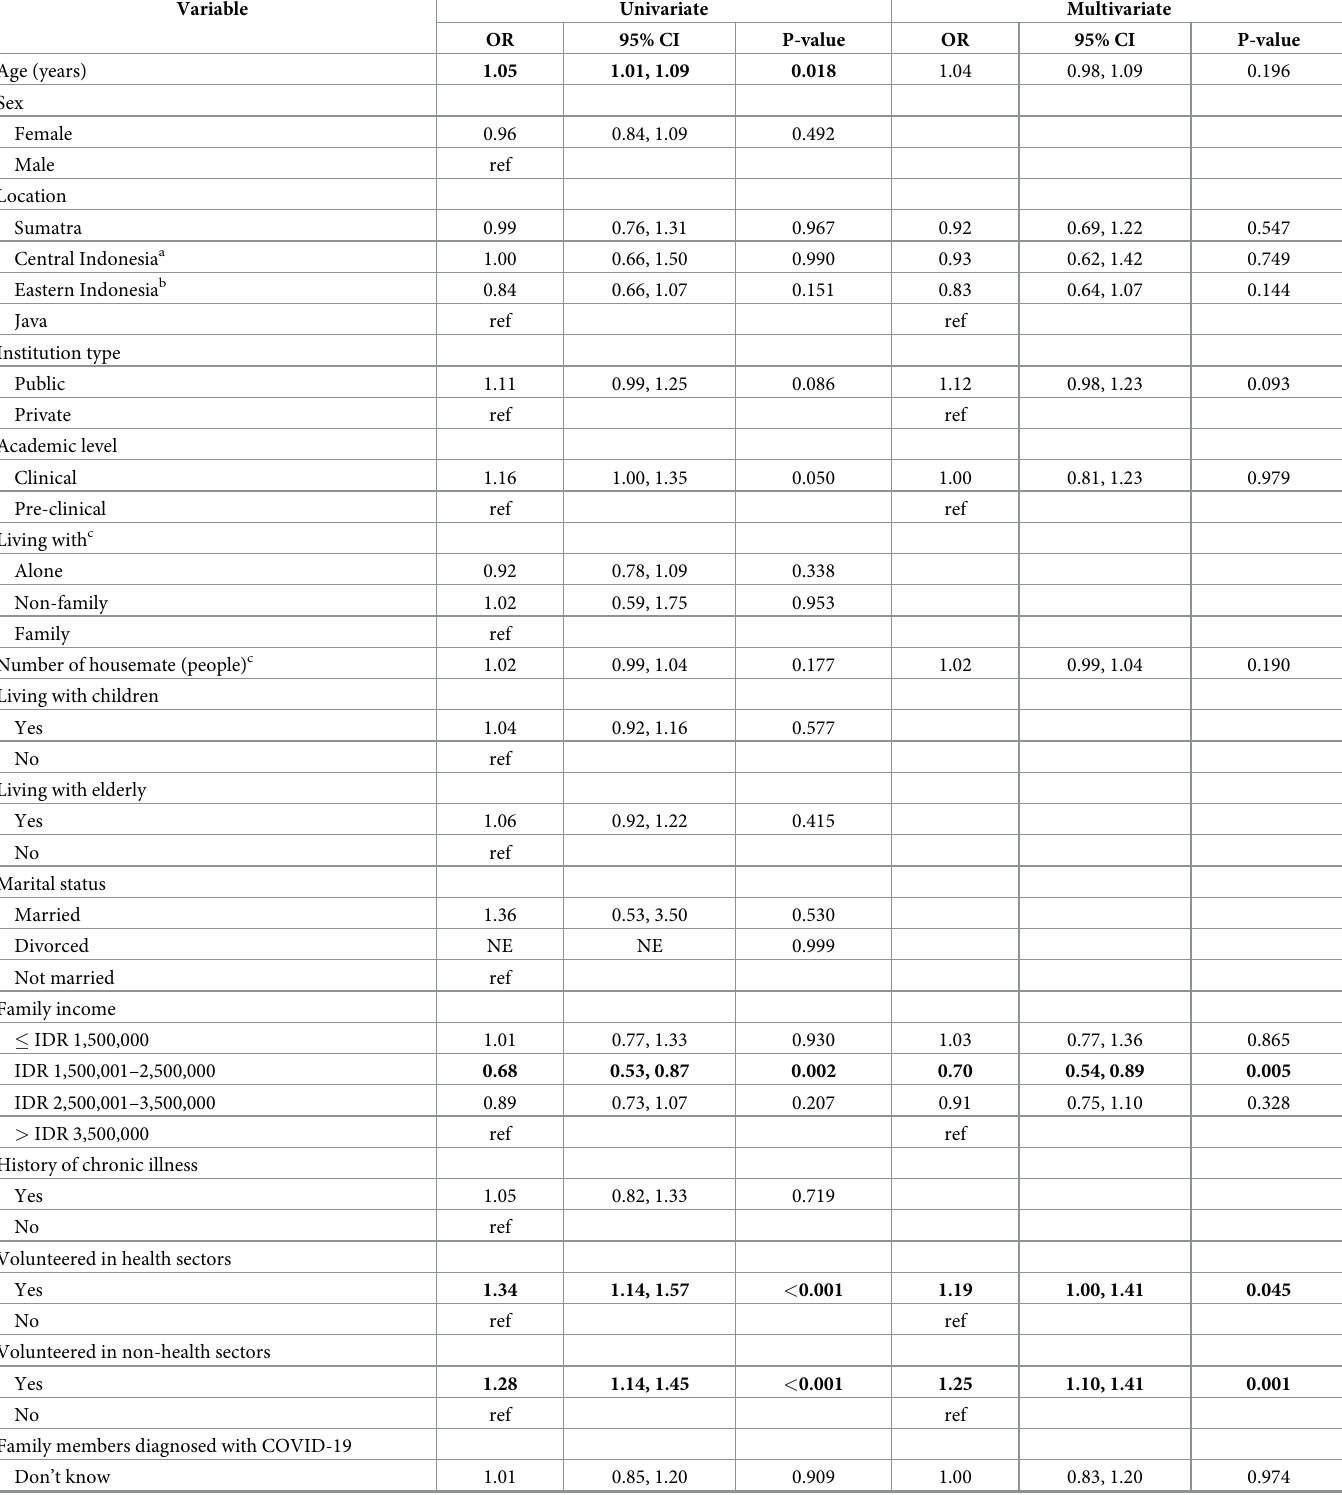
Table 2. Factors associated with attitude toward COVID-19 in the study population (n =